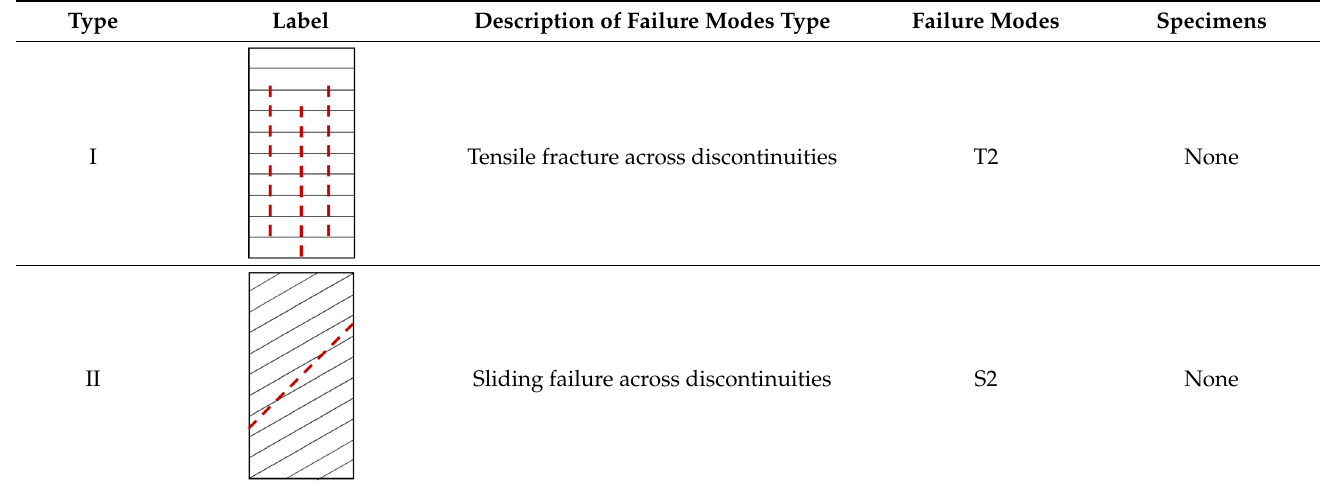
Table 4. Classification of ultimate failure mode in the present experimental results.